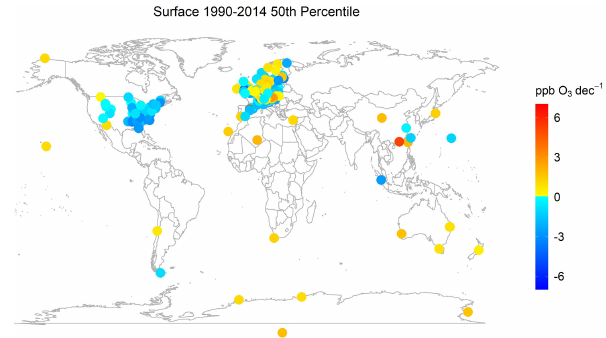
Figure 5. 1990–2014 daytime surface ozone trends (ppb per decade) at sites compiled in the TOAR database. Warm colors indi- cate increasing trends, and cool colors indicate decreasing